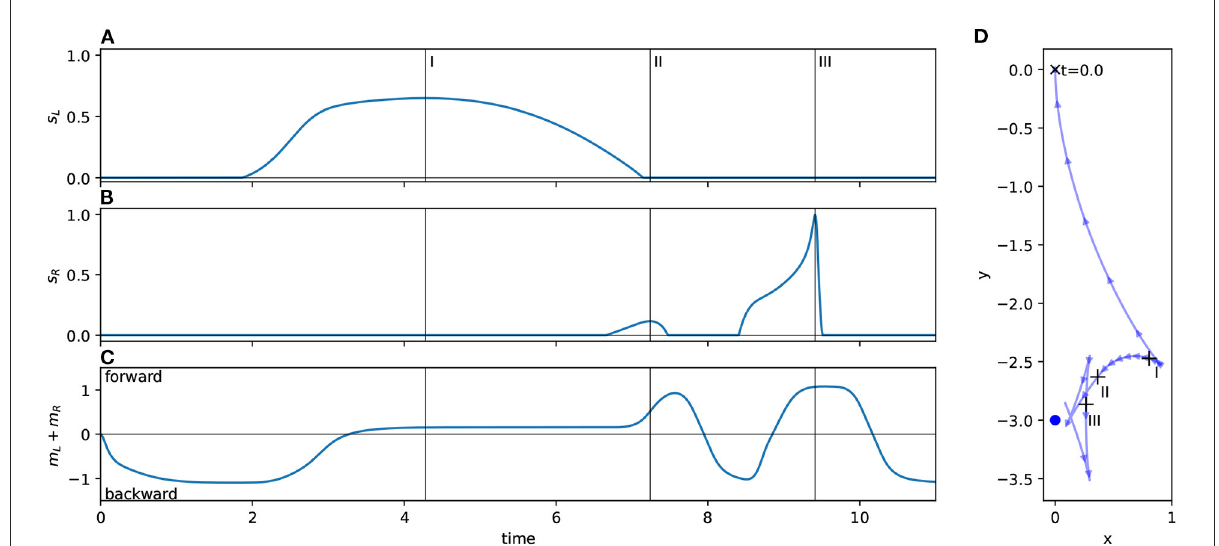
FIGURE5 An example approach phase (Phase A) for the ancestral solution which is guided by the left sensor. (A–C) Show the sensorimotor activity of the ancestral solution when the light is at coordinates (0, –3), position 6 in Figure 3. (D) Plots the spatial trajectory of the robot. The vertical lines in plots (A–C) show the peaks in sensor activity. These correspond to the + markers in (D) . Initially the robot drives backwards. The left sensor stimulation between t 2 and t 8 is associated with the robot to driving forwards while turning strongly to the left. Once this turn has oriented = = the robot such that the right sensor is being stimulated and the left sensor is no longer being stimulated, the robot drives forward until the right sensor is no longer stimulated. From here, this is just the same Phase B behavior presented in Figure